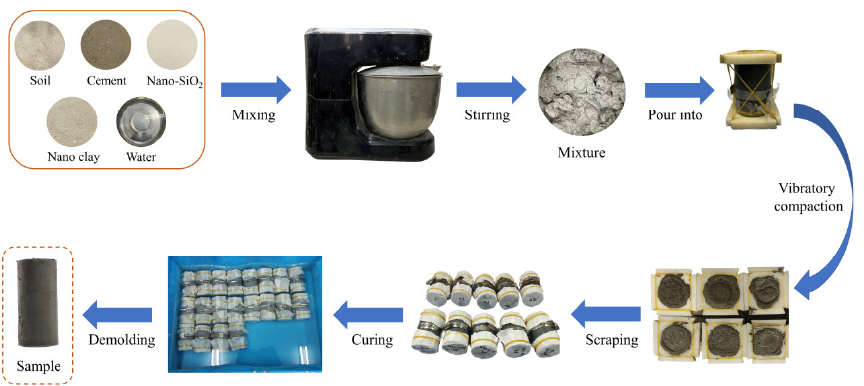
Figure 1. Sample preparation process.